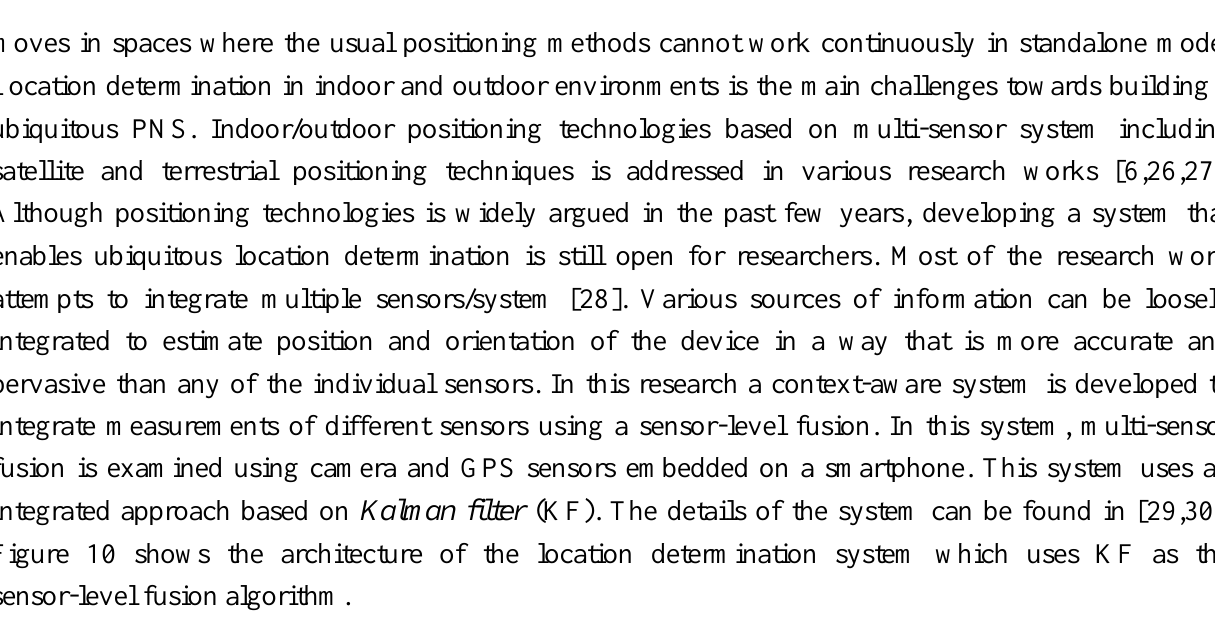
Figure 10. Multi-sensor pedestrian navigation diagram using context-aware vision-aided